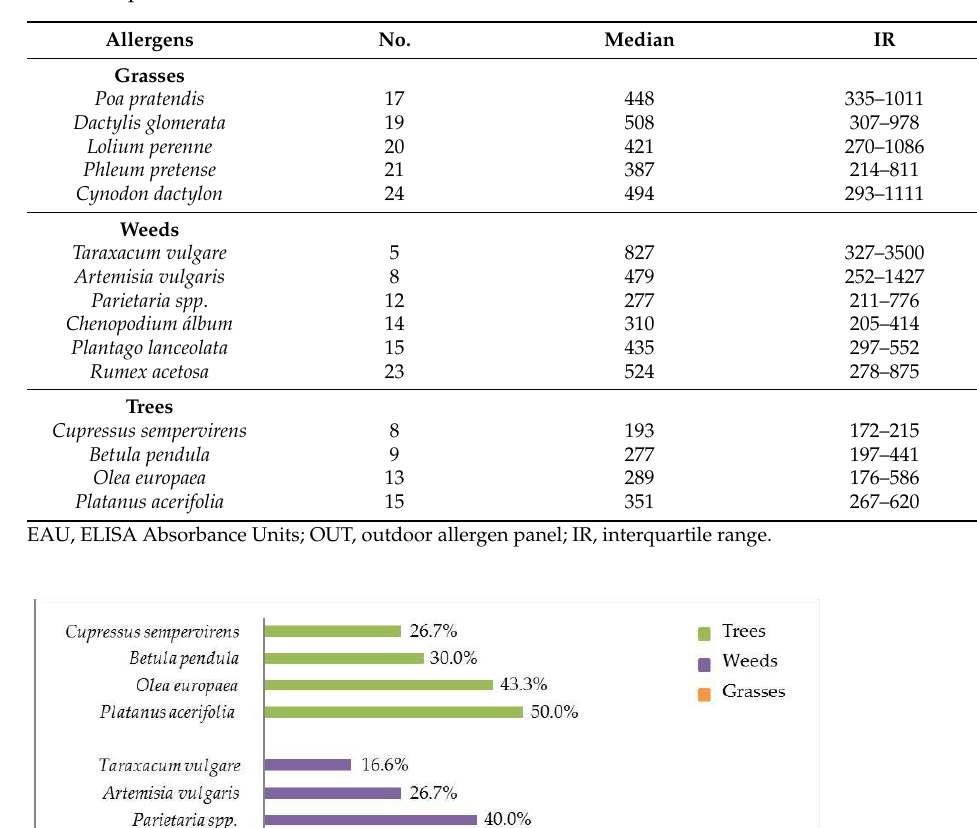
Table 4. Serum IgE concentrations (EAU) of various allergens in OUT positive subjects ( n = 30) with canine atopic dermatitis.